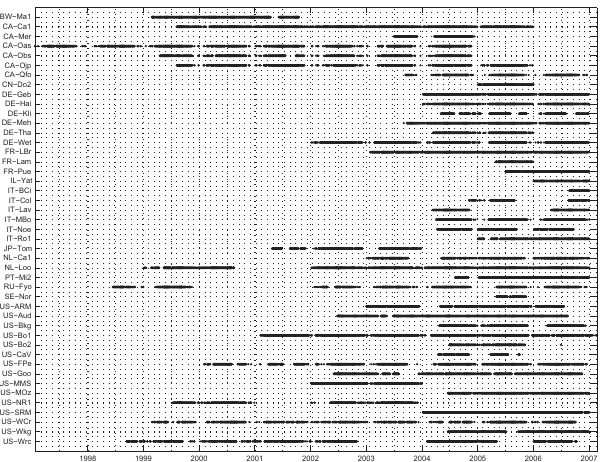
Figure A1. Temporal duration of the eddy-covariance-based flux and tower meteorological observations for each of the 45 sites used in this study.